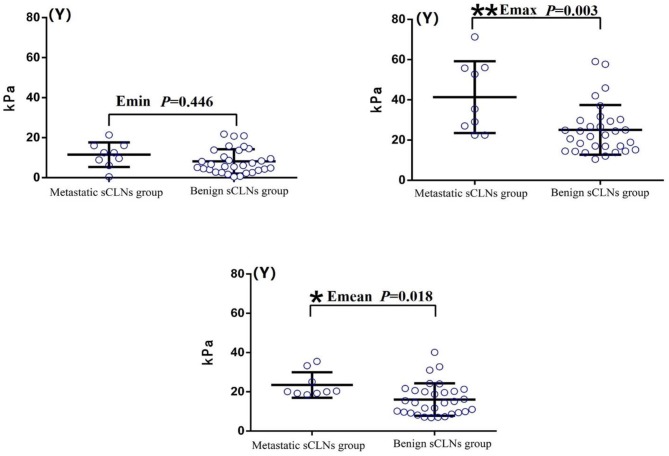
Comparison of elasticity values (Y-axis) of Shear wave elastography between benign and metastatic small cervical lymph nodes (sCLNs) groups in scatter plot. There was no significant difference between the Emin (Minimum elasticity values) between benign and metastatic sCLNs groups (P = 0.446 > 0.05). The differences of the Emax (Maximum elasticity values) and Emean (Mean elasticity values) between benign and metastatic sCLNs groups were statistically significant (**P = 0.003 < 0.005 and *P = 0.018 < 0.05).